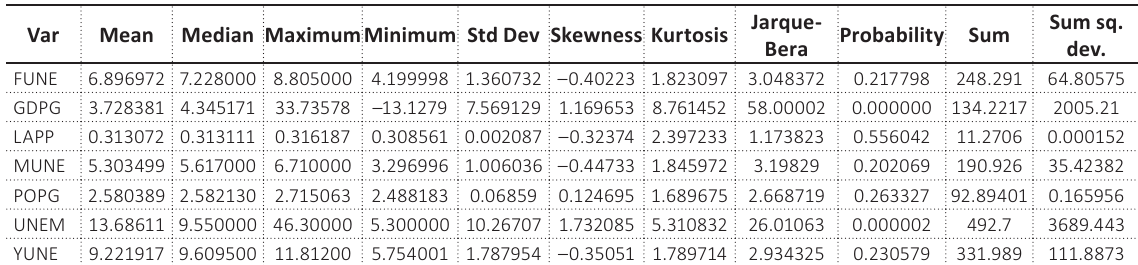
Table 3. Unit root test